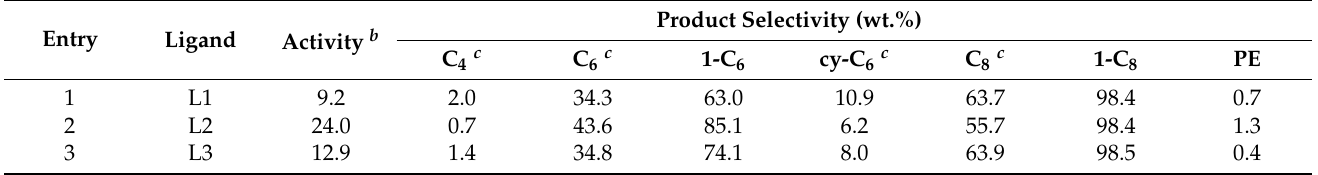
Table 1. Evaluation of L1–L3 ligands for selective ethylene oligomerization a